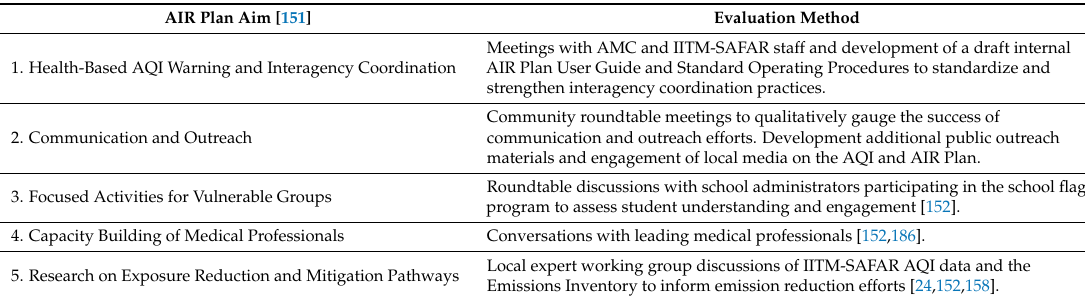
Table 2. Key aims of the AIR Plan and corresponding evaluation